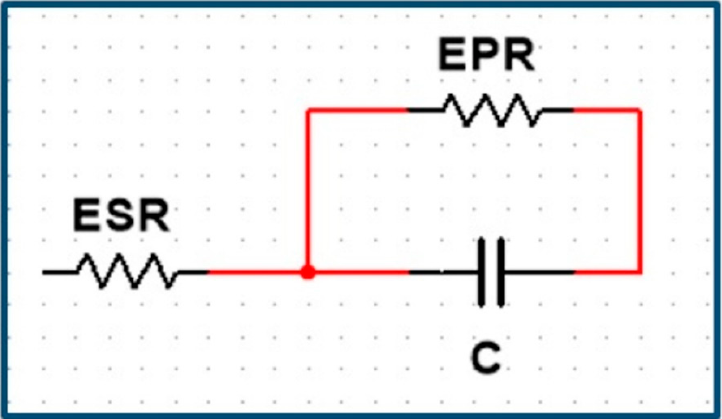
Figure 1. Basic RC model [11].